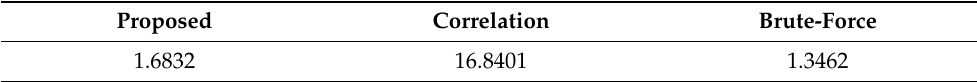
Table 1. Average position errors (in pixels) of the entire Figure 4 experiment.